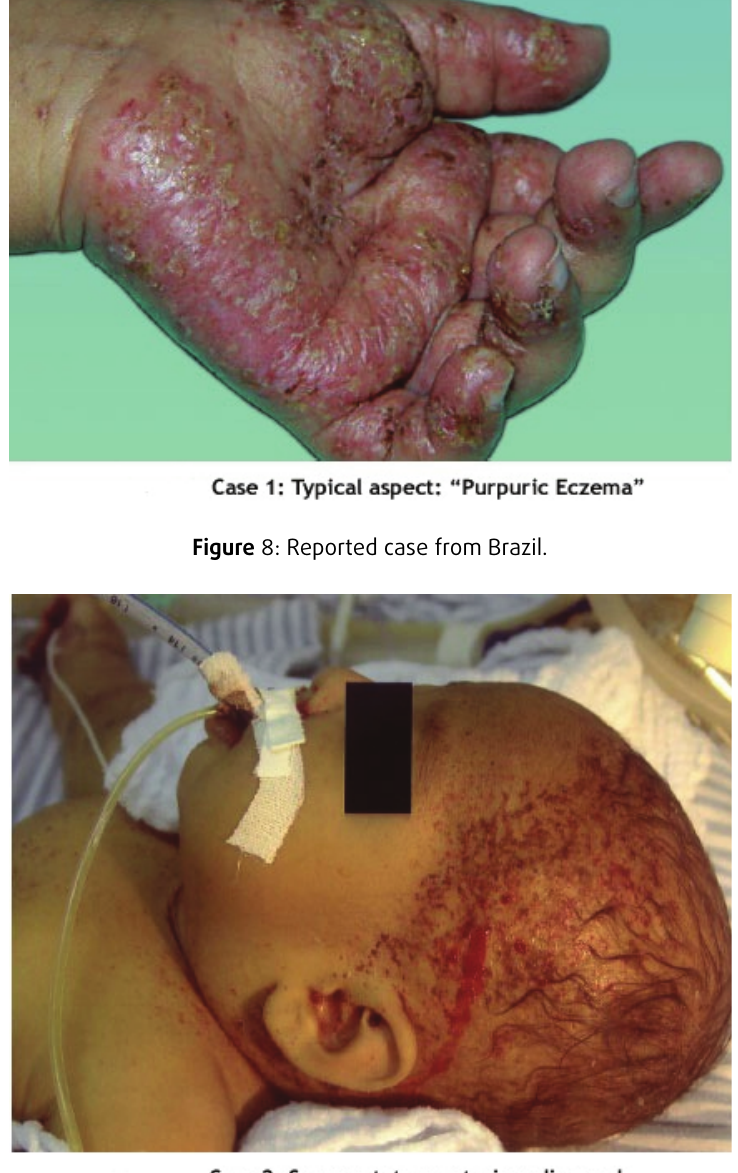
Figure 9: Reported case from